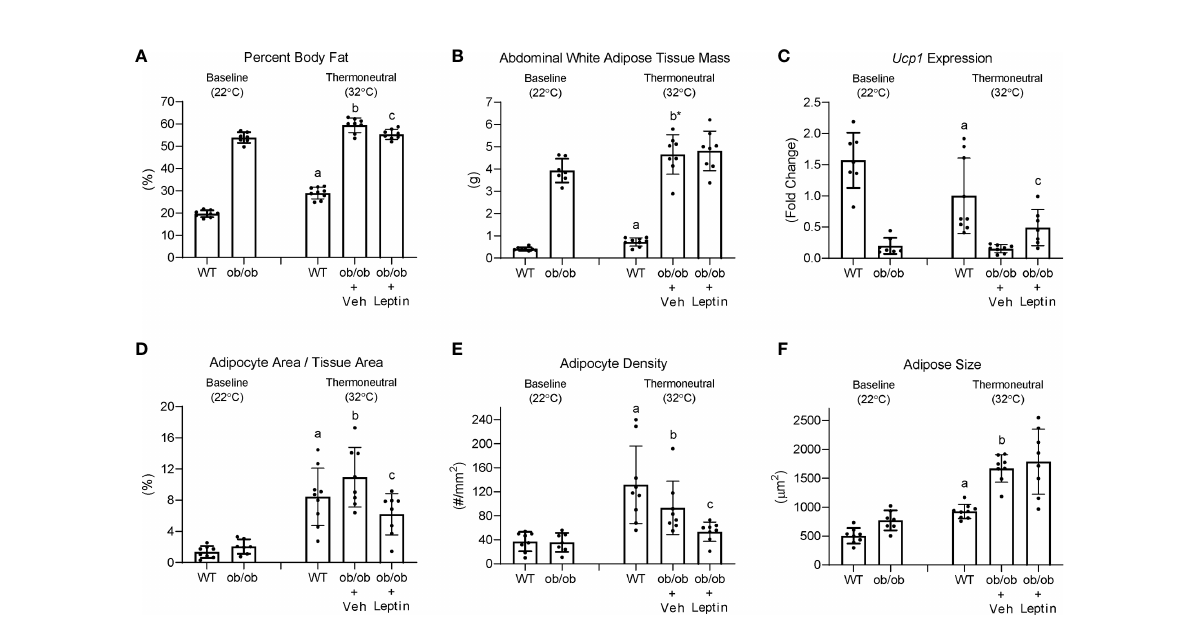
FIGURE 7 Effects of temperature and leptin administration on percent body fat (A) , abdominal white adipose tissue mass (B) , brown adipose tissue Ucp1 gene expression (C) and on adipocyte area fraction (D) , adipocyte density (E) , and adipocyte size (F) in distal femur metaphysis in ob/ob female mice. Data are mean ± SD with individual data points shown as dots. N = 7-9/group. Analysis of variance followed by appropriate posthoc tests was used to assess differences among groups. a WT control (32°C) different from WT baseline (22°C), FDR-adjusted P < 0.05. b ob/ob + vehicle control (32°C) different from ob/ob baseline (22°C), FDR-adjusted P<0.05; b * FDR-adjusted P < 0.1. c ob/ob + leptin different from ob/ob + vehicle control, FDR-adjusted P <